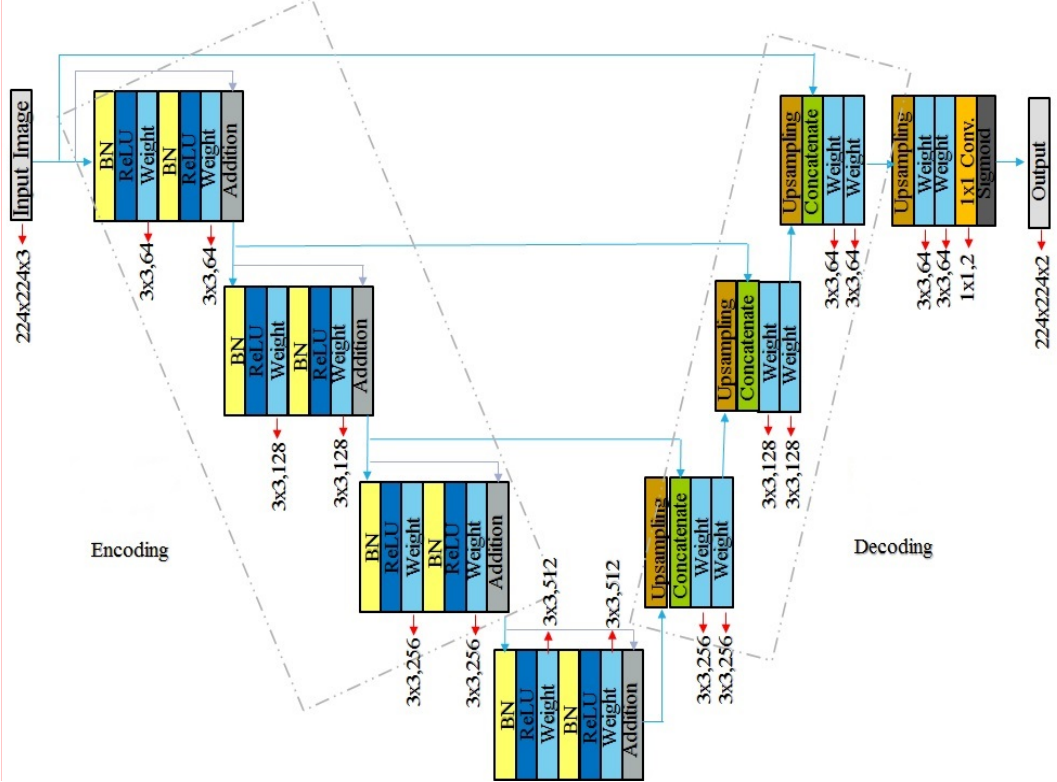
Figure 1. Proposed model.